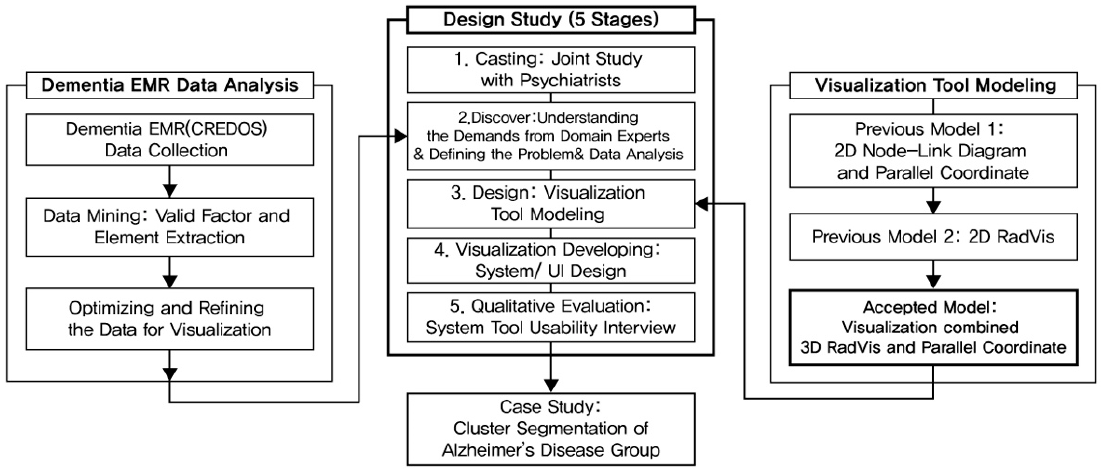
Figure 1. Research framework.